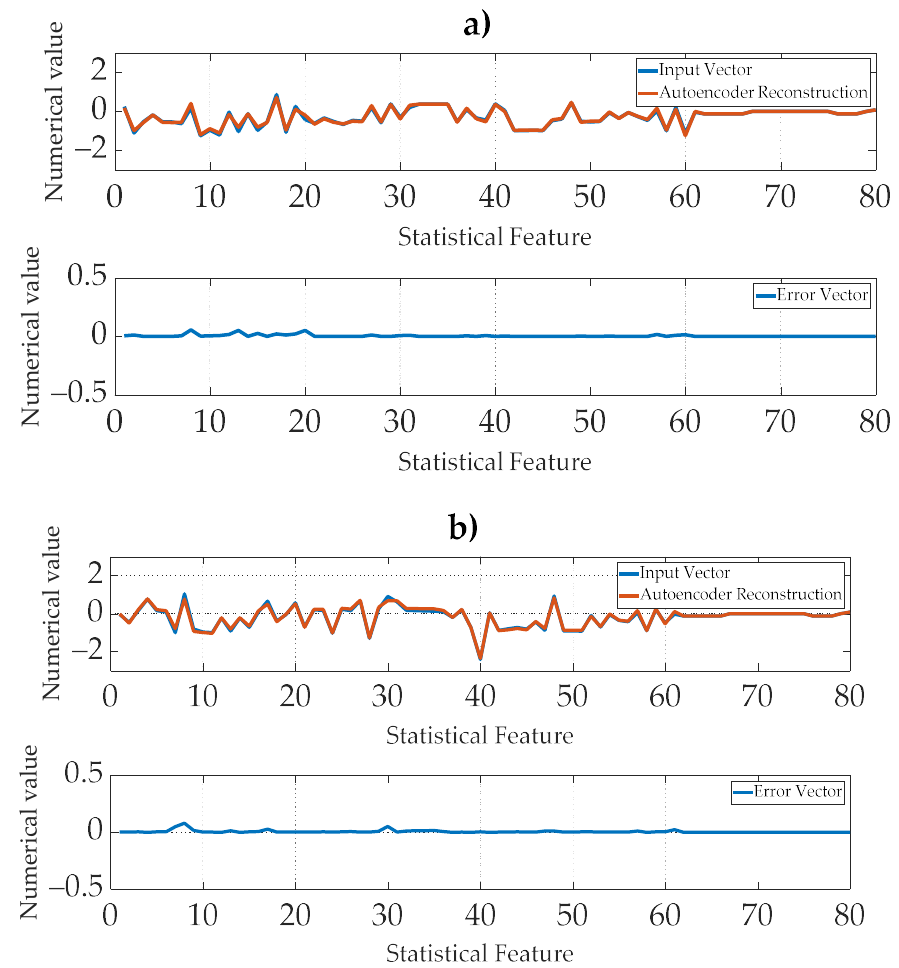
Figure 5. Original feature signals, its reconstruction and the resulting errors. ( a ) Signal including flicker disturbance; ( b ) Signal including harmonic and oscillatory transient disturbances. In x -axis, 1–20: Time features; 21–40: Frequency features; 41:80 Time-frequency features. In y -axis, numerical value of statistical features.